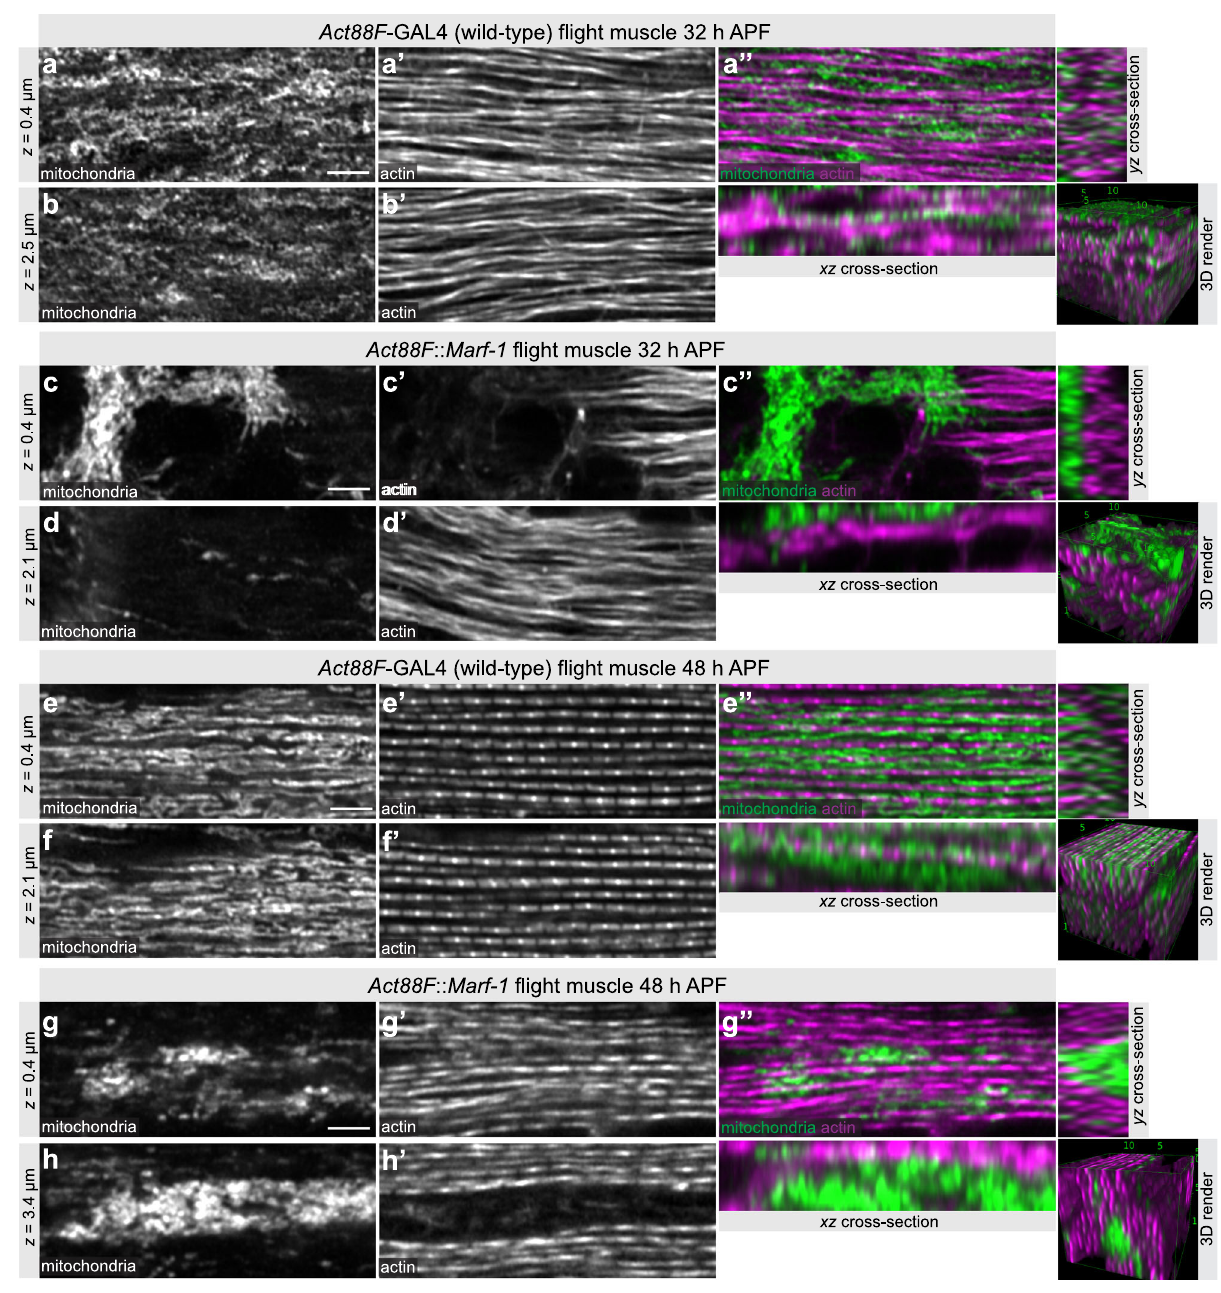
Fig. 8 Mitochondria isolate individual myo fi brils. a – h Developing wild-type fl ight muscles at 32 h after puparium formation (APF) ( a , b ) and 48 h APF ( e , f ), compared to Act88F ::Marf-1 fl ight muscles at 32 h APF ( c , d ) and 48 h APF ( g , h ). See also Supplementary Movie 9. Mitochondria were visualised by immunostaining against complex V (ATPase) and actin with phalloidin. Note how mitochondria isolate myo fi brils in wild type ( e ″ ) but fail to do so in Act88F::Marf-1 with mitochondria clustering centrally ( g ″ ). Scale bars are 2.5 µ